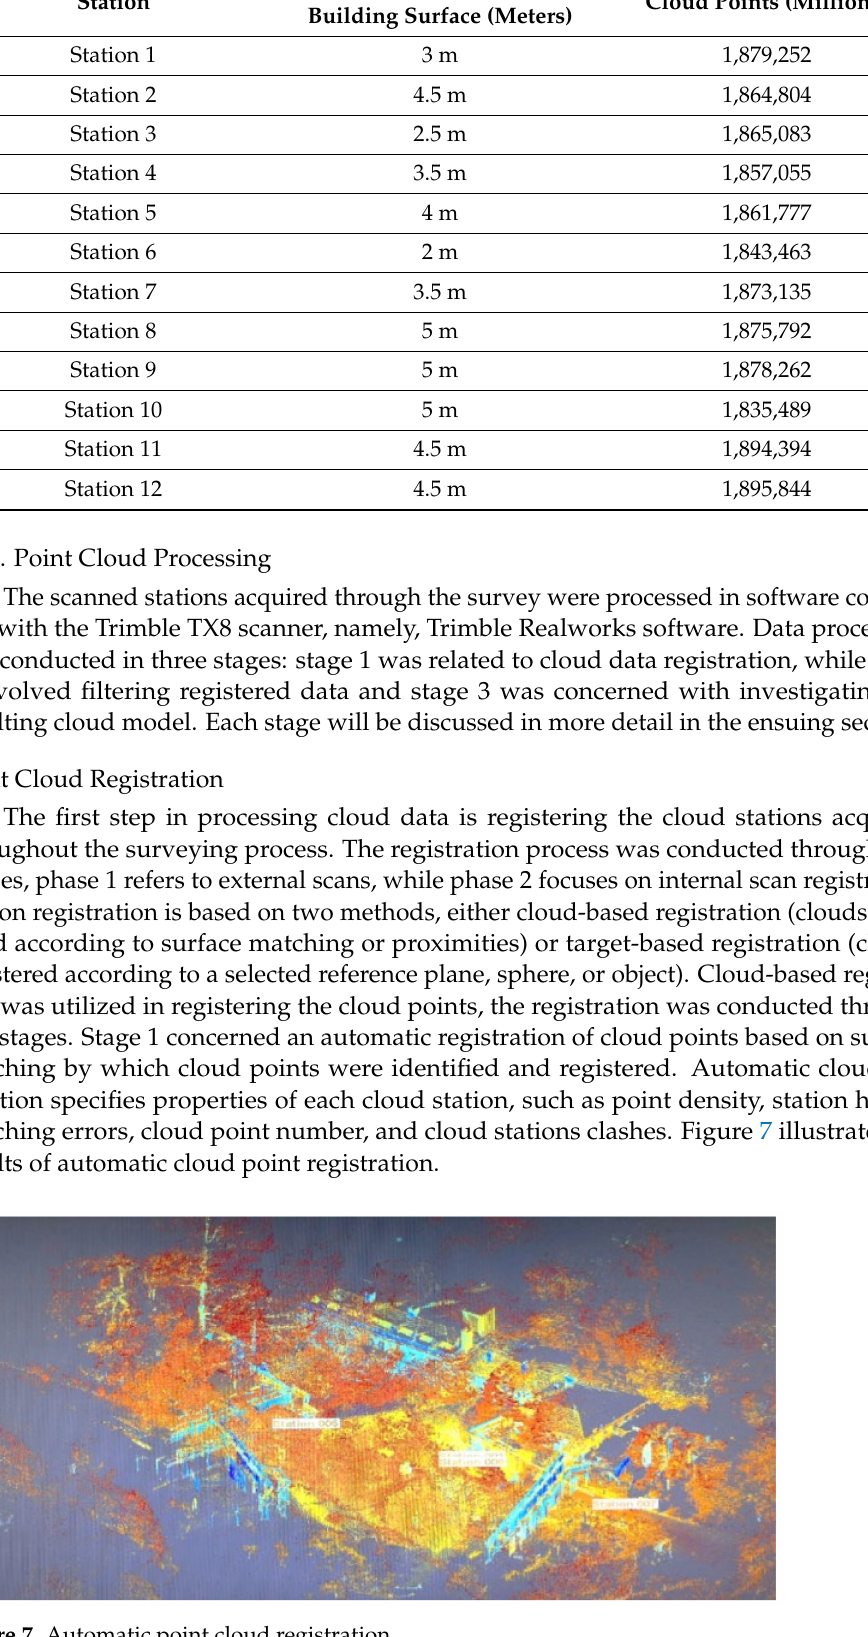
Figure 7. Automatic point cloud